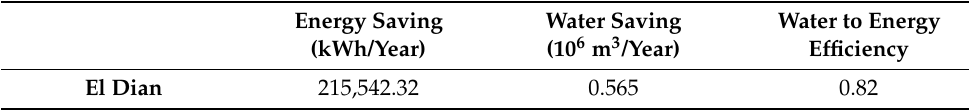
Table 5. Savings in “El Dian”